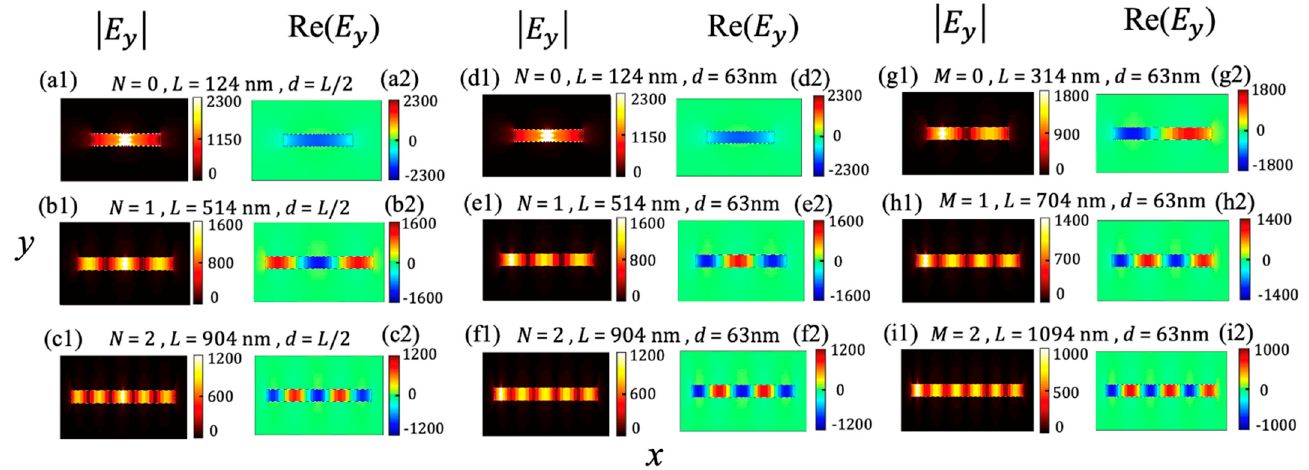
Figure 4. Under the point-source excitation, the distributions of the dominant electric-field component E y at plane z = h /2 in the aperture, which are obtained with the full-wave a-FMM. (a)–(c) correspond to the first three resonance peaks ( N = 0, 1, 2 ) in Figure 2(a). (d)–(i) correspond to the first six resonance peaks ( N = 0, 1, 2, M = 0, 1, 2 ) i n Figure 2(b). The superimposed dotted lines show the aperture boundary. E y in the figure is normalized (divided by Γ water ).